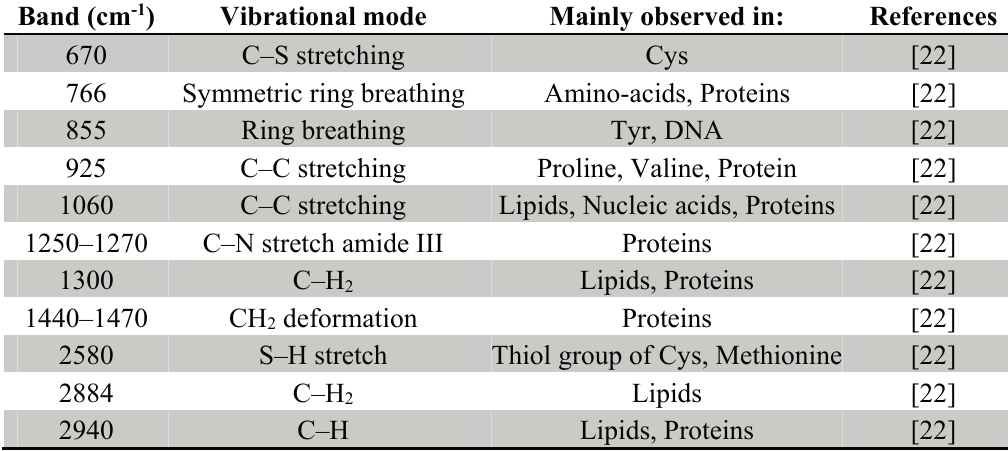
Table 2. Main Spectro-Fluor™ vibrational assignments of the p21 protein. Band (cm -1 ) Mainly observed